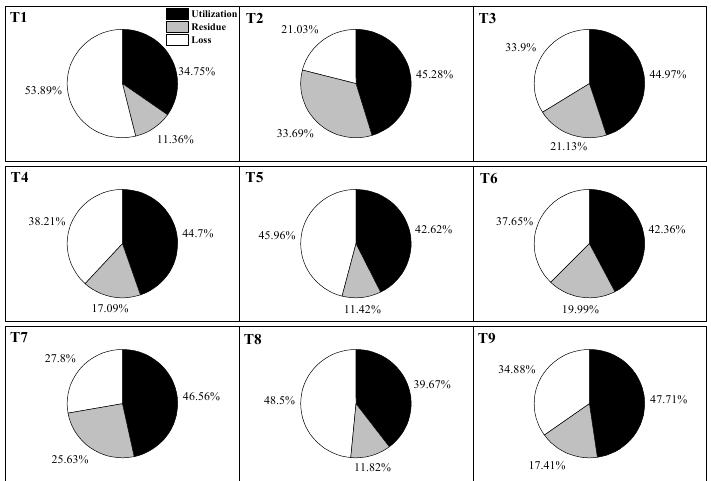
Figure 4. The rate of 15 N fertilizer loss under different treatments.